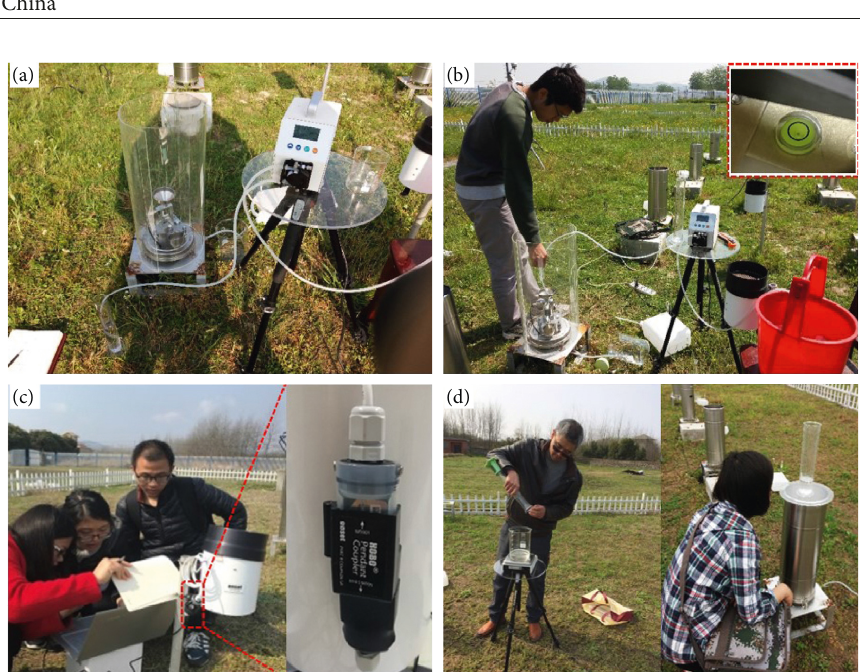
Figure 2: (a) Peristaltic pump used for calibration. (b) The calibration of tipping bucket rain gauge. (c) Obtaining the data from RG3-M (left), the data logger (right). (d) Comparison of precipitation measurement for the manual gauge: weighting method (left) and horizontal visual method